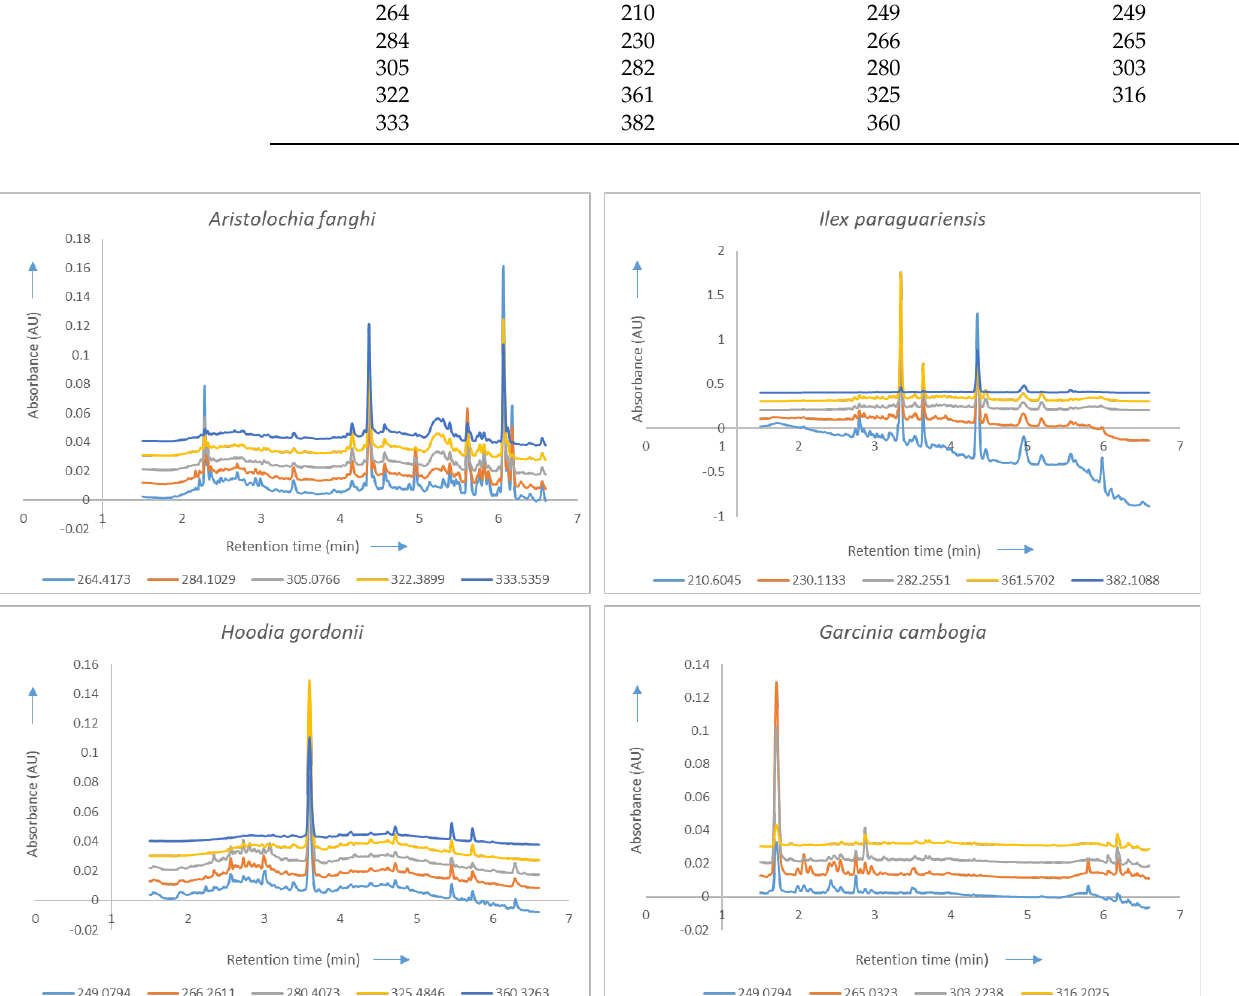
Figure 2. Overlays of the chromatograms of the concerned plants represented at their selected wavelengths (nm) with the X -axis representing retention time (in minutes) and the Y -axis representing the absorbance (in absorbance units). An offset of 0.01 is added to the chromatograms to provide a better overview of the overlaid wavelengths of each reference plant . Table 1. Selected wavelengths (nm) for all 4 plants .